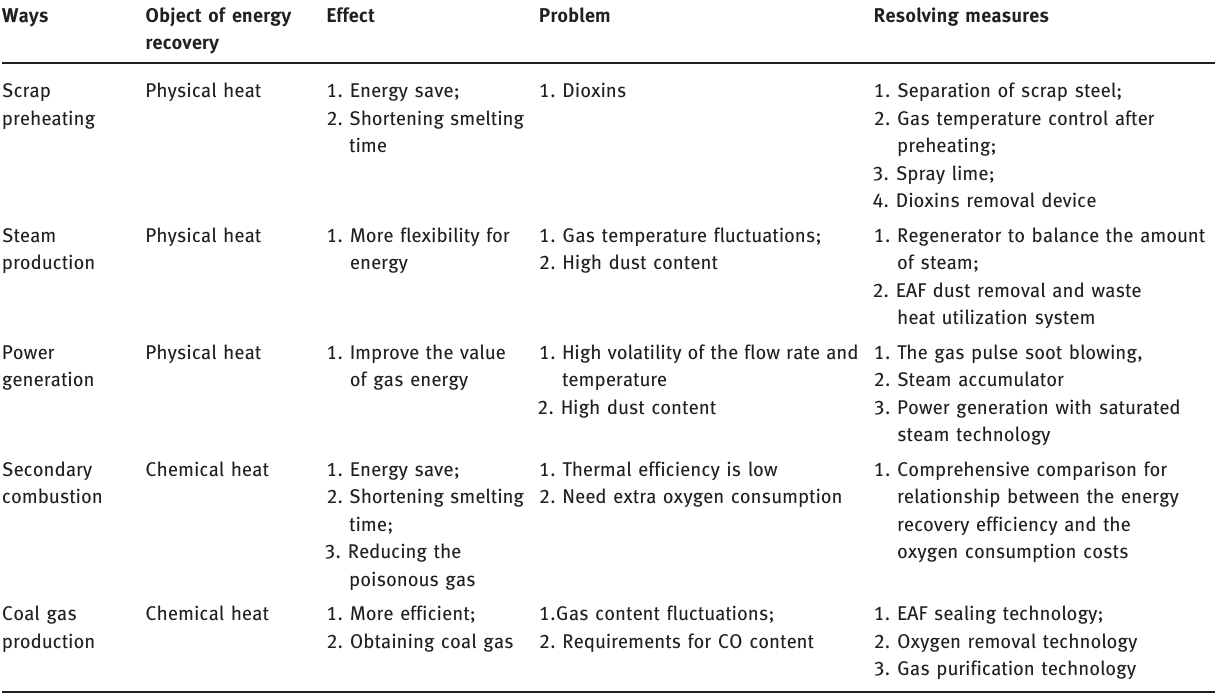
Table 3: Contrast of EAF waste heat